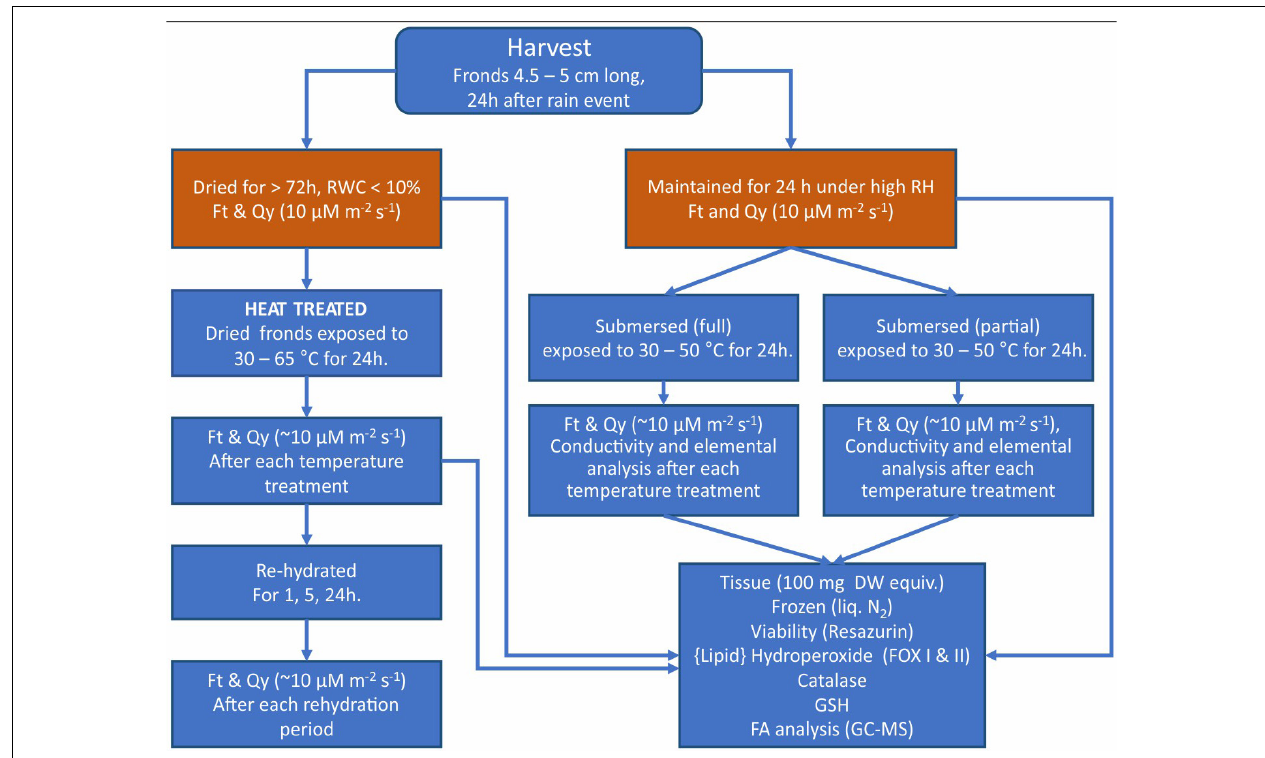
FIGURE 1 | Summary of the workflow of experiments and analyses performed on dried, rehydrated, and submersed Pleopeltis fronds. Data obtained from the initial sample status (red boxes) served a reference for all other